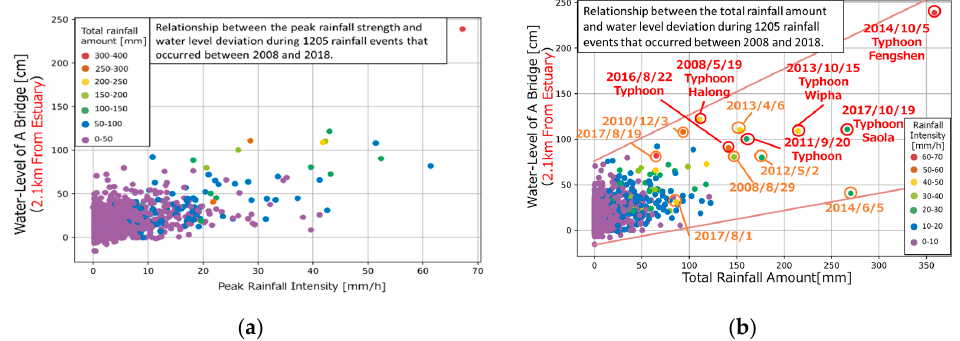
Figure 3. ( a ) Relationship between peak rainfall intensity and water level deviation; and ( b ) relationship between total rainfall and water level deviation.